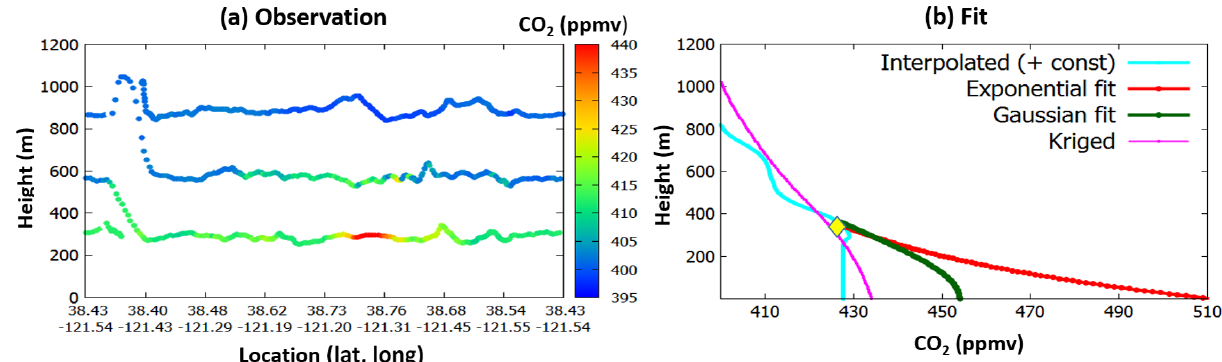
Figure 3. (a) Observed CO 2 over the Sacramento loop on 18 November 2013. (b) The vertical profiles of calculated CO 2 mixing ratios around 38.75 ◦ N, 121.27 ◦ W. The yellow diamond indicates the altitude of the lowest flight data. The kriged values (magenta), interpolated values with exponential weighting function, and extrapolated values using constant (cyan), Gaussian fit (green), and exponential fit (red) are compared. The empirical fits were generated based on the approach by Gordon et al.